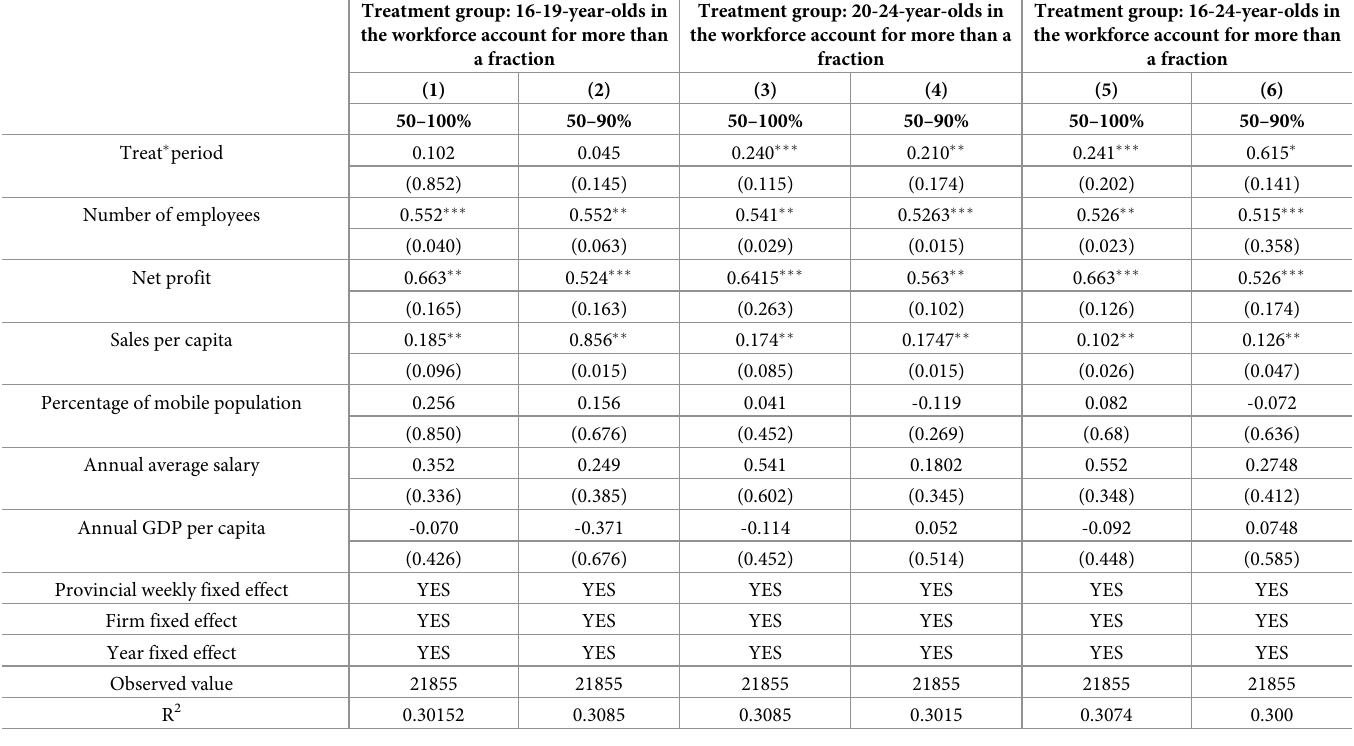
Table 3. Impact of rising labor costs on innovation inputs of private